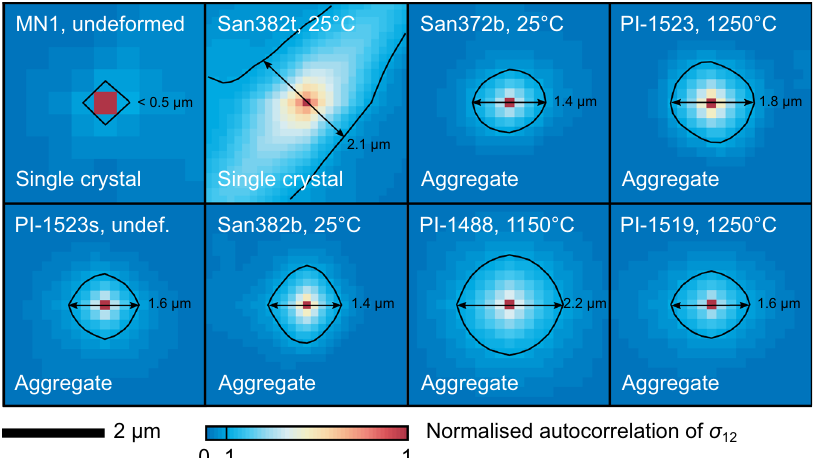
Fig. 6 Autocorrelation functions of stress heterogeneity. Autocorrelation functions of stress heterogeneity, normalised σ 12 , are normalised to unit peak height. The central 4 × 4 μ m of the autocorrelation function is plotted for each sample. Black contours correspond to values of 0.1, which is the maximum off-peak value present in the autocorrelation function from the undeformed single crystal, sample MN1. Marked dimensions indicate the width of the region within the 0.1 contour. Annotations indicate the sample number, fi nal deformation temperature and whether the sample is a single crystal or an